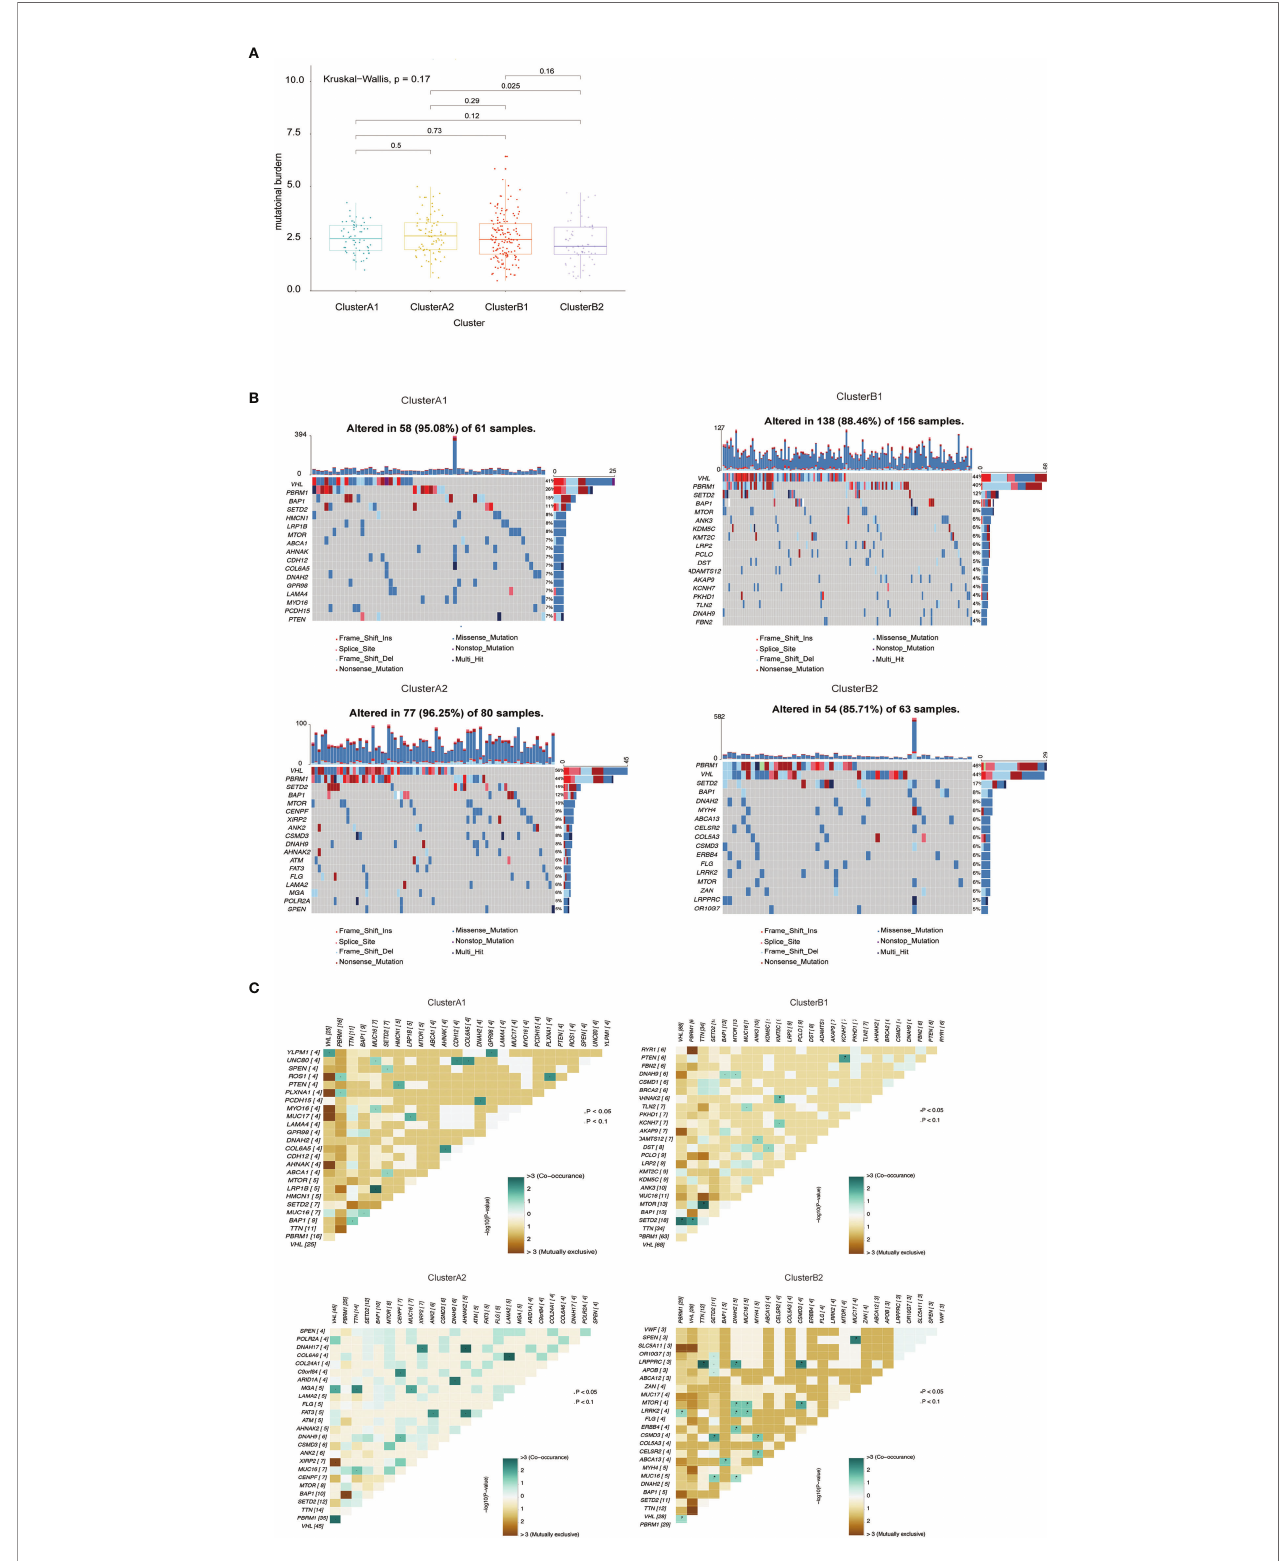
FIGURE 4 | (A) Barplot of mutation load among various immune clusters. (B) Waterfall plot of mutational pro fi les among various immune clusters. (C) Overview of mutational coexistence and mutual exclusion